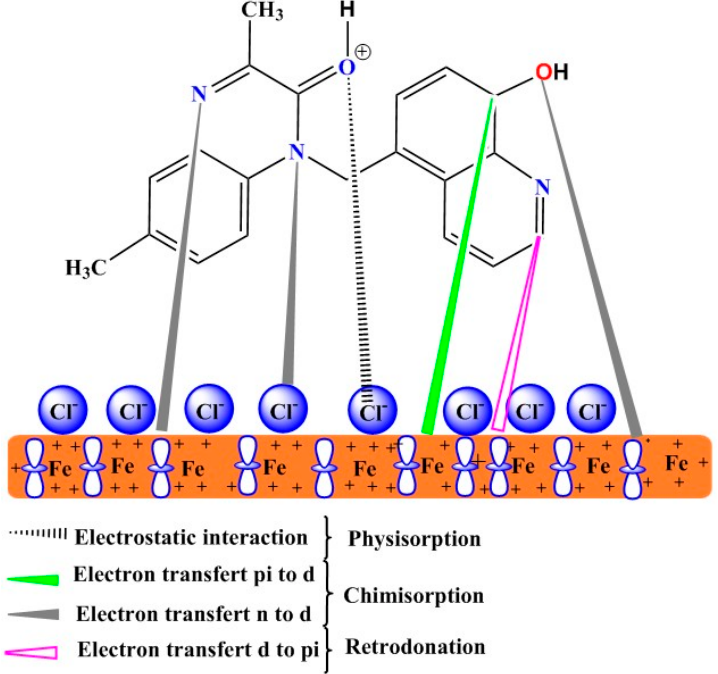
Figure 12. Schematic anti-corrosion mechanism of MS in the presence of Q1 inhibitor in 1 M HCl.